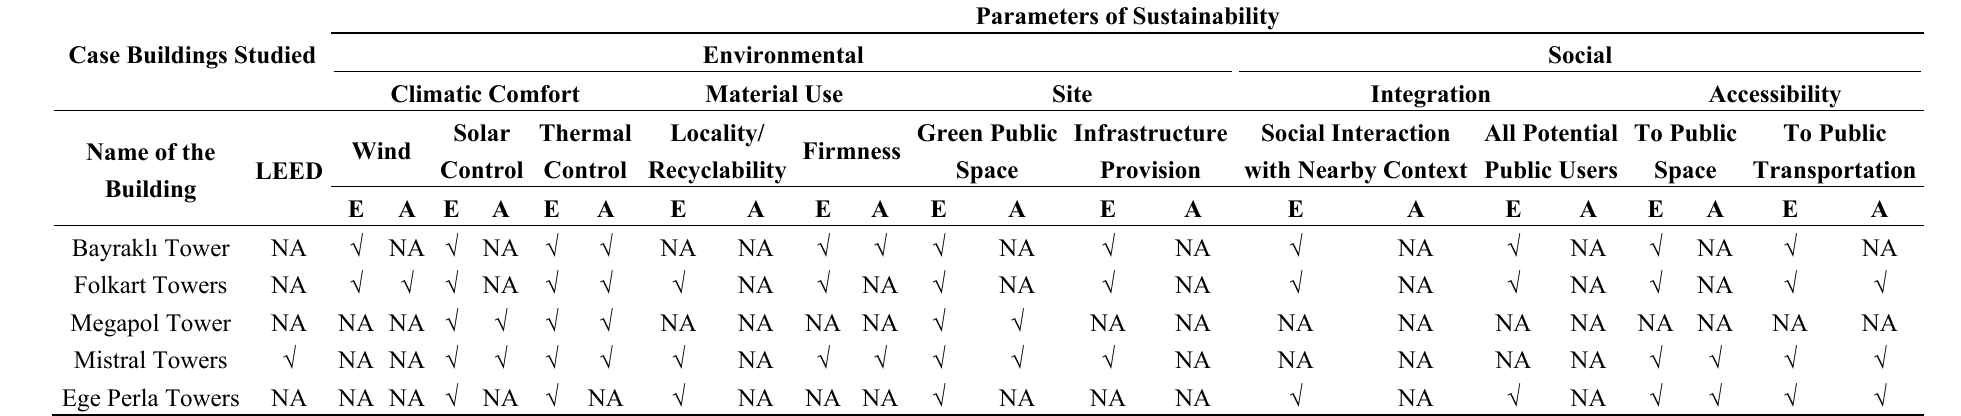
Table 3. Parameters of sustainability applied to case buildings studied (E: Employed; A: Advertised; NA: Not Applicable). Case Buildings Studied